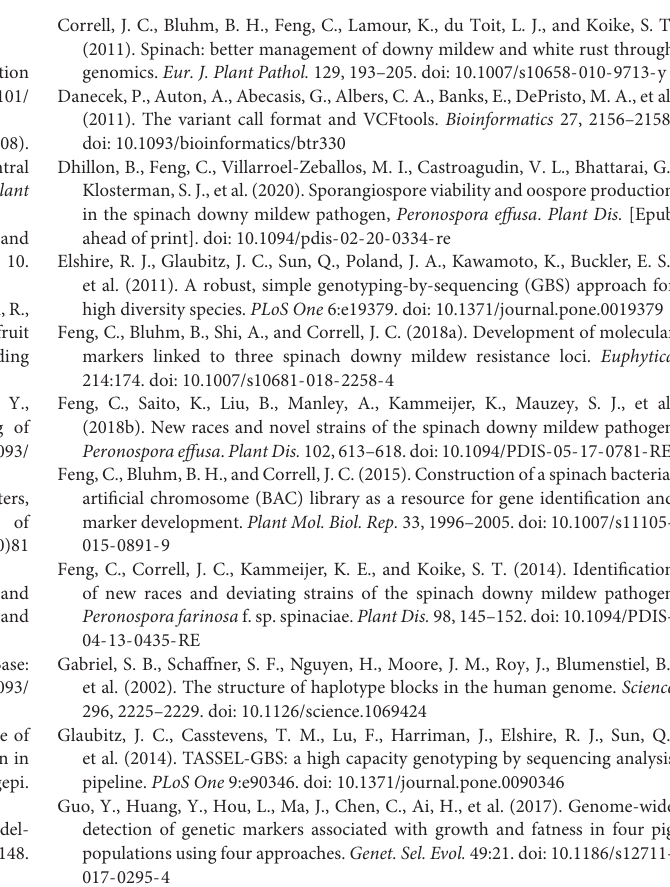
Supplementary Figure 1 | Population structure of the spinach lines generated from a cross of cultivars Swan and Whale. (A) Optimum K was determined using the minimum cross-validation errors in the data for K. (B) Classification of spinach genotypes in the association panel into two genetic sub-populations. The horizontal axis represents the spinach genotypes, and the vertical axis of the plot represents the probability of genotypes belonging to different genetic groups. Two colors indicate membership proportion to each population group. Supplementary Figure 2 | Manhattan and QQ-plots of genome wide associations of the race 13 of P. effusa resistance in spinach population generated from a cross of Swan and Whale in TASSEL (A) , GAPIT (B) , PLINK (C) , and GENESIS (D) model. The horizontal and vertical axis represents the genomic position of the SNP and association power for each SNP with the trait expressed as − log 10 ( P -value). The dashed line shows the Bonferroni-corrected genome wide